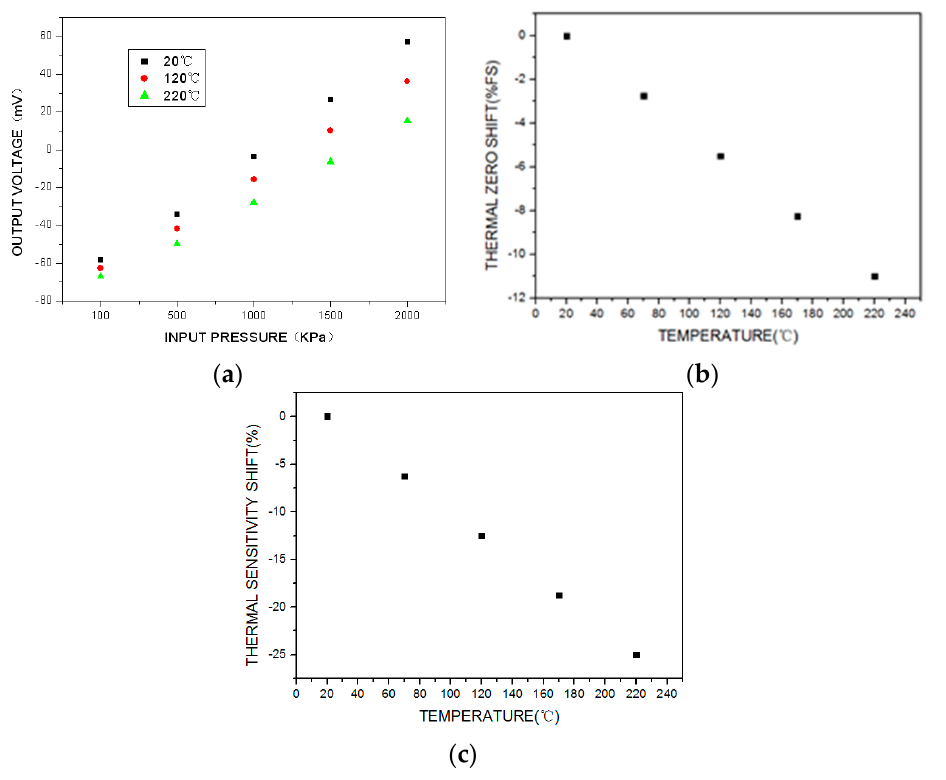
Figure 8. Test results for the uncompensated high-temperature pressure sensor: ( a ) output voltage calibration curve in the temperature and pressure environment; ( b ) thermal zero shift; ( c ) thermal sensitivity shift.